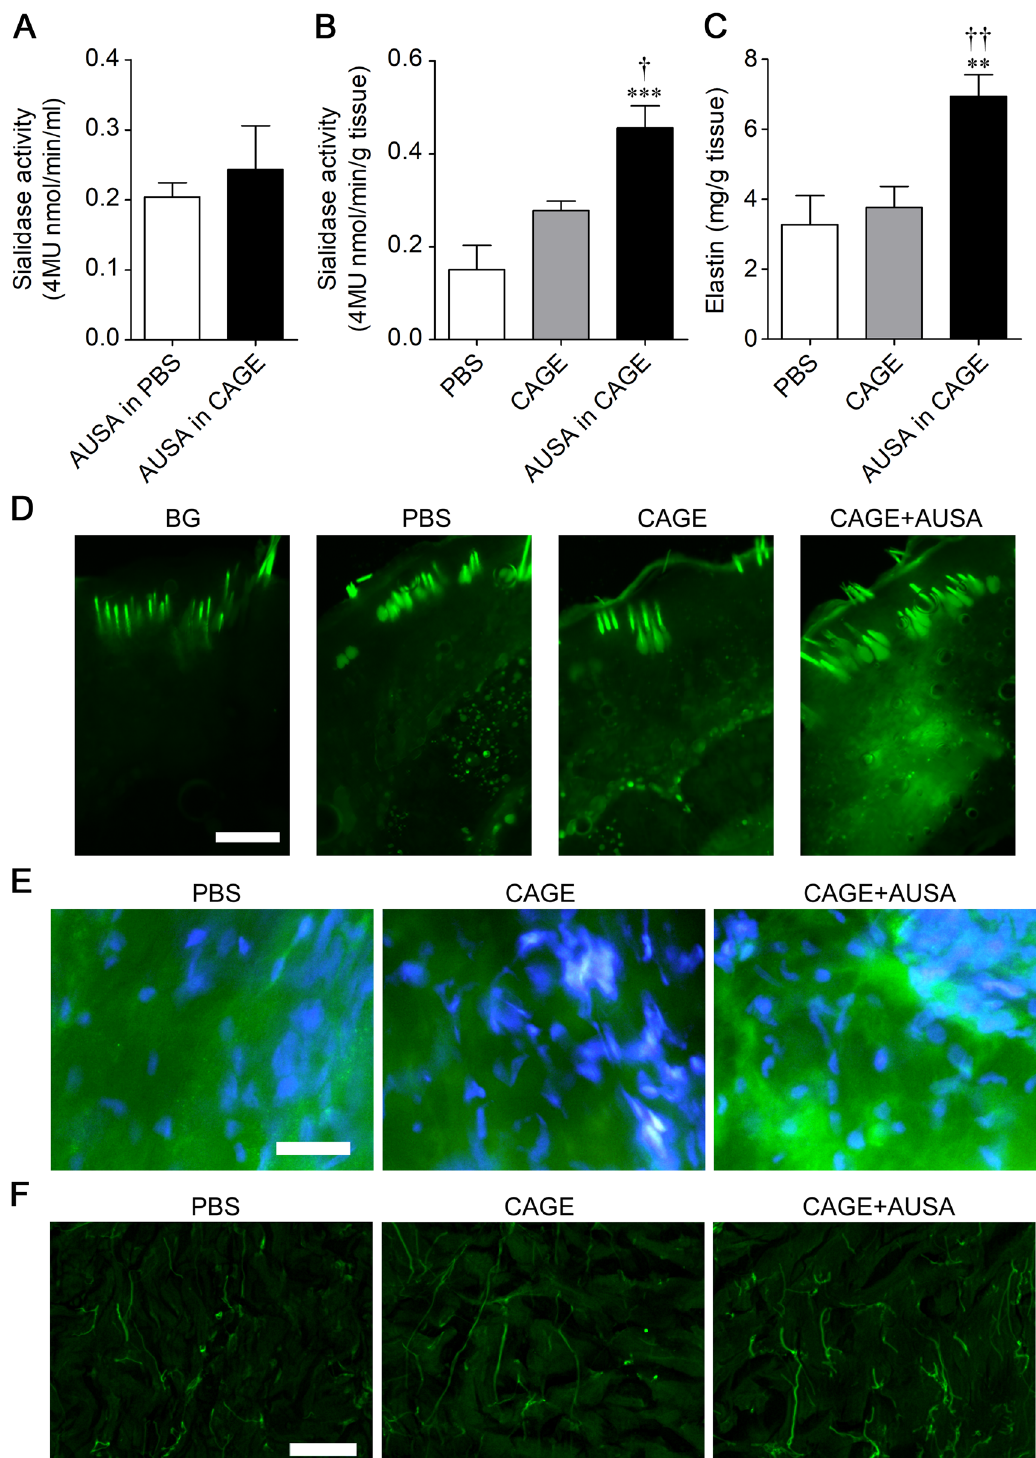
Figure 2. Enhancement of elastin expression in the rat skin by sialidase. ( A ) Enzyme activity of AUSA was measured with 4MU-Neu5Ac at 28 days after dissolving AUSA in CAGE. ( B , C ) Sialidase activity ( n = 5–8, B ) and elastin level ( n = 7–8, C ) in the rat lateral abdomen skin were measured after applying PBS, CAGE, or AUSA in CAGE on the skin twice a day for 5 days. ** P < 0.01, *** P < 0.001 vs. PBS; † P < 0.05, †† P < 0.01 vs. CAGE (one- way ANOVA with Bonferroni’s multiple comparison test). ( D ) Sialidase activity imaging with BTP3-Neu5Ac (pH 7.3) in the rat lateral abdomen skin after applying PBS, CAGE, or AUSA in CAGE on the skin. Scale bar, 500 μm. ( E ) Immunohistochemical staining of elastin in extension sections of the dermis. Elastin: green, DAPI: blue. Scale bar, 300 μm. ( E ) Autofluorescence in the dermis. Scale bar, 50